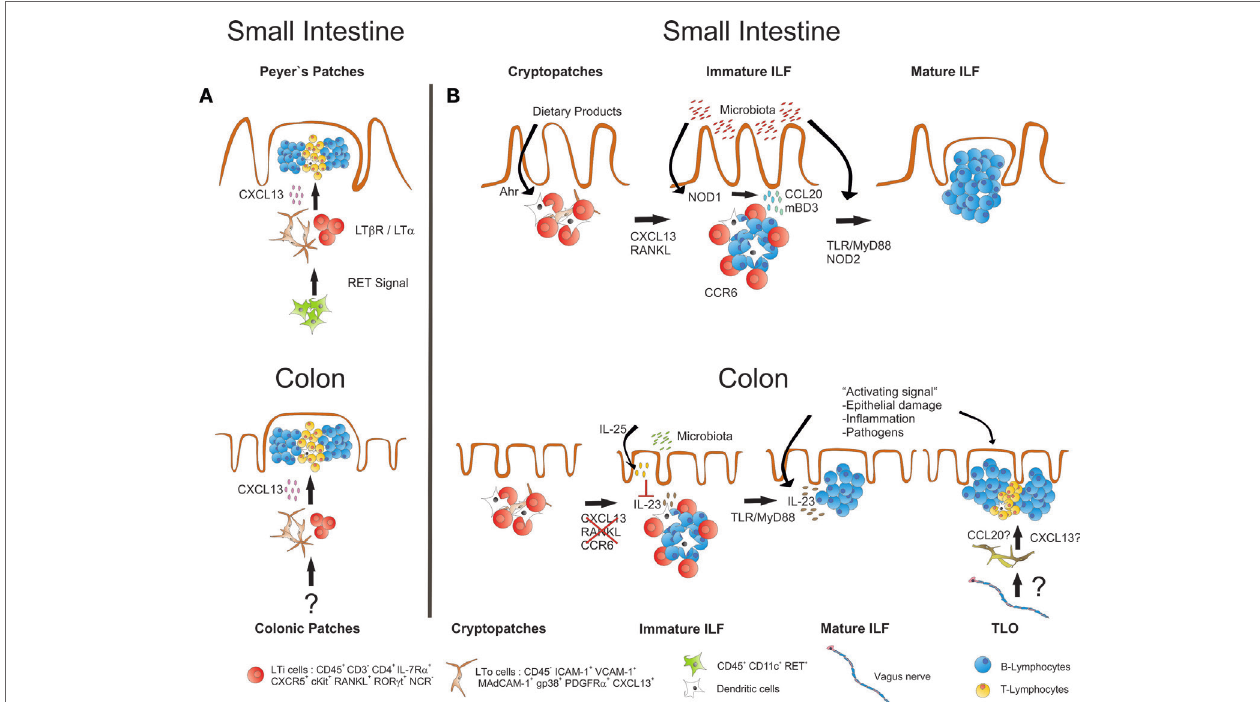
FiGURe 2 | Similarities and differences in the development of small intestinal and colonic lymphoid tissues . (A) Development of both PP and colonic patches starts before birth with the clustering of LT α 1 β 2 -expressing IL-7R α + ROR γ t + LTi cells together with LTo cells. LTi cell clustering and further development of both PP and colonic patches requires expression of CXCL13 and is dependent on LT-signaling. Whether the initial clustering of LTi cells in the colon depends on RET-expressing IL7R α − CD11c + cells, as it has been described for PP development, is not known. (B) ILF formation in both small intestine and colon starts after birth with the clustering of IL-7R α + ROR γ t + LTi cells in CP. Maintenance and further development of these structures into ILF requires LT signaling in both small intestine and the colon. In the small intestine, also signaling via the Ahr and the expression of CXCL13, RANKL and CCR6 is required, and the commensal microbiota induce ILF formation and maturation via activation of signaling pathways that include NOD1, NOD2, TLRs, and MyD88. In the colon, ILF formation does not seem to critically depend on CXCL13, RANKL, and CCR6. There, the presence of commensal microbiota rather inhibits ILF maturation, probably by inducing IL-25 production from the epithelium, which in turn diminishes the secretion of IL-23, a cytokine that specifically promotes ILF maturation in the colon. Signals associated with intestinal inflammation or infection with enteric pathogens also induce ILF formation and maturation. Intestinal inflammation or infection may also result in the induction of TLO that form independently of LTi cells. TLO may be discriminated from ILF by structural differences such as the presence of T cell areas. A role for the intestinal nervous system for TLO induction in intestinal inflammation has been